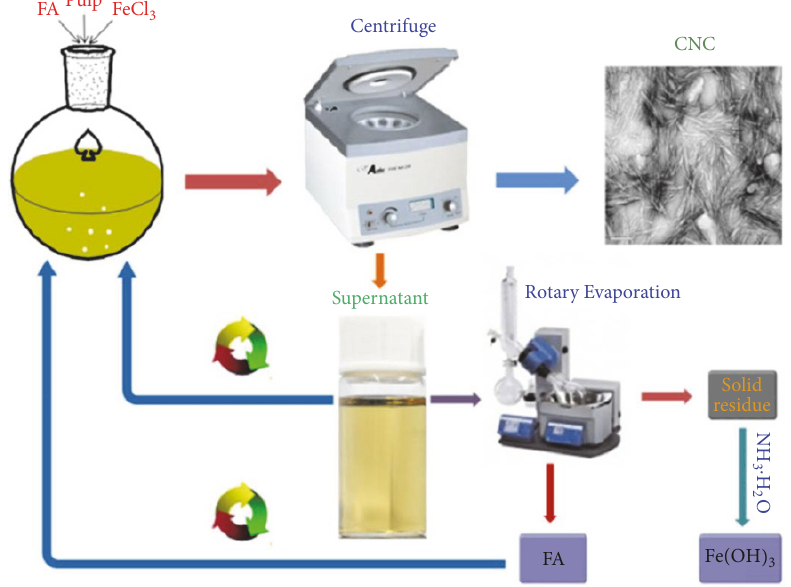
Figure 4: Overall flow-process diagram of the preparation of CNCs by FeCl 3 /FA hydrolysis